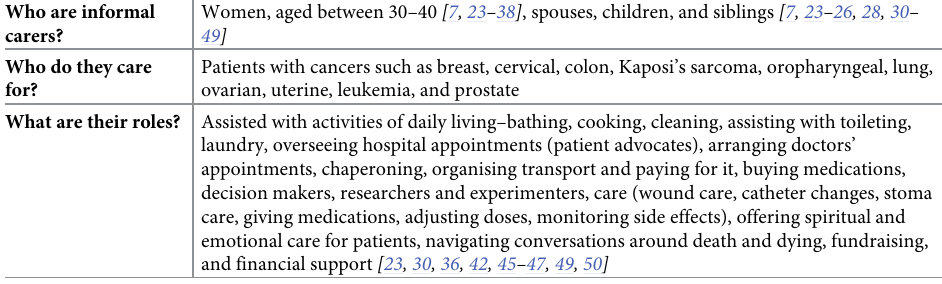
Table 3. Characteristics and roles of informal carers.